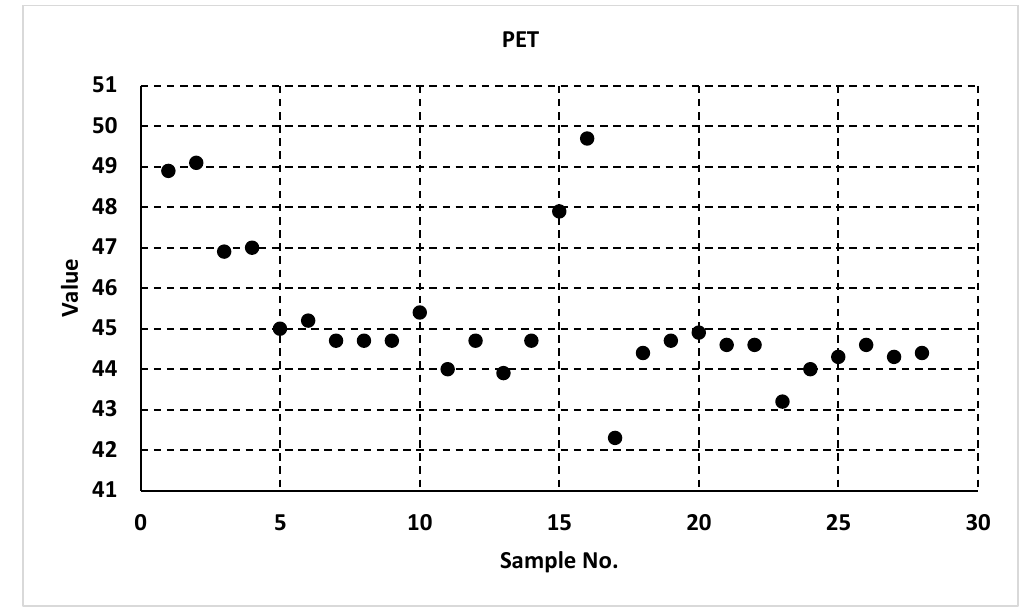
Figure 11. Variation of Physiological Equivalent Temperature (PET) values.